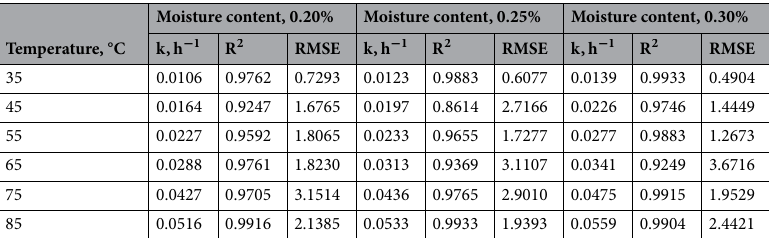
Table 3. Rate constant for CPO FFA kinetics ( n = 0.5, i.e., half-order reaction).